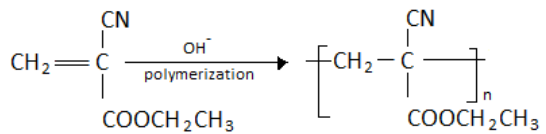
Figure 1. Schematic reaction of ethyl 2-cyanoacrylate towards production of poly(ethyl 2-cyanoacrylate) PECA.